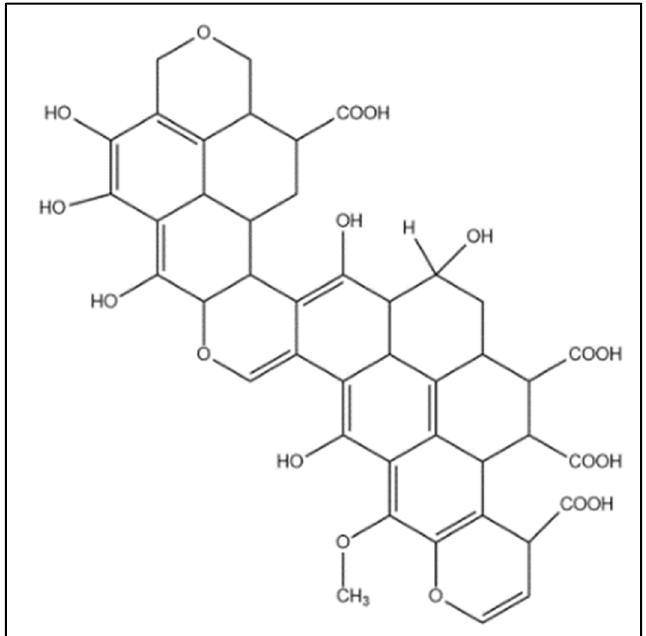
Figure 4. HA molecular structure.